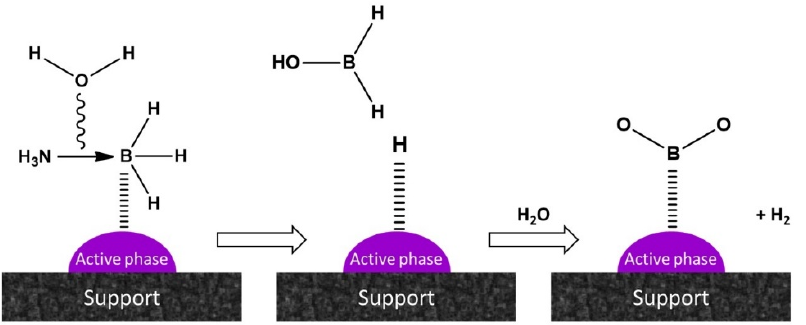
Figure 2. Mechanism proposed for hydrogen production from the hydrolysis of ammonia borane (AB). Adapted from [63].